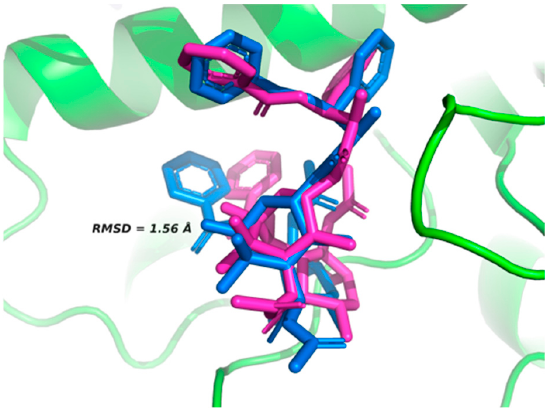
Figure 2. Ligand-binding site of β -tubulin protein with co-crystalized native taxol (blue) and taxol as posed by the Autodock Vina program (pink).